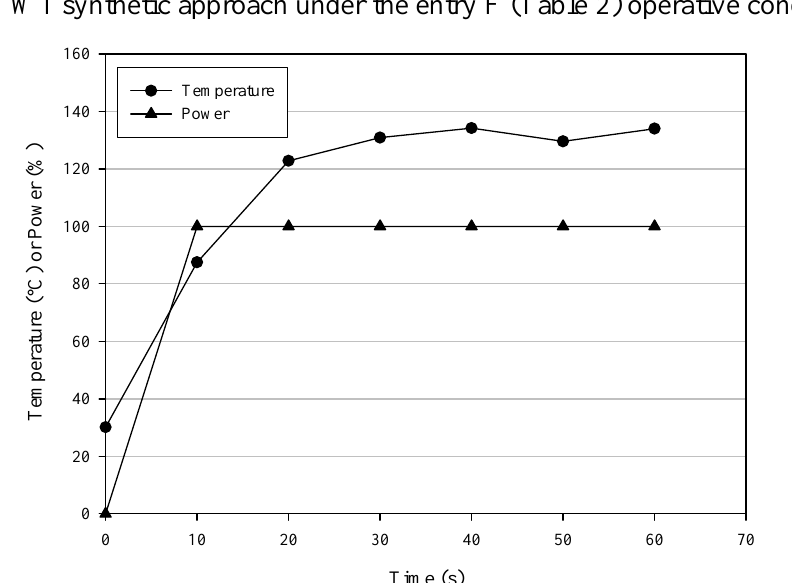
Figure 1. Graph of temperature and power % vs time for the synthesis of pyrazole a following MW1 synthetic approach under the entry F (Table 2) operative